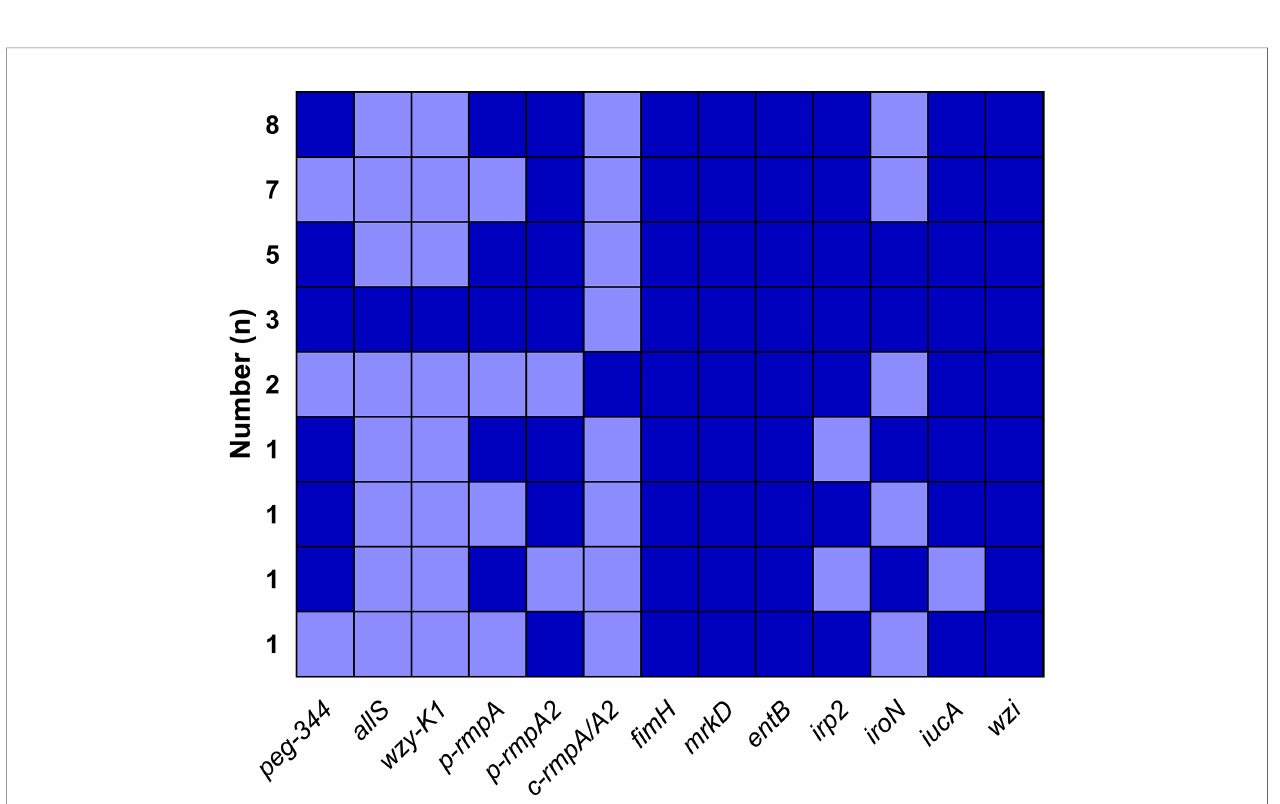
FIGURE 5 | Modes of virulence genes in Hv- bla KPC (+)-KP. The presence of virulence genes is represented by a dark blue box and the absence of others is represented by a light blue